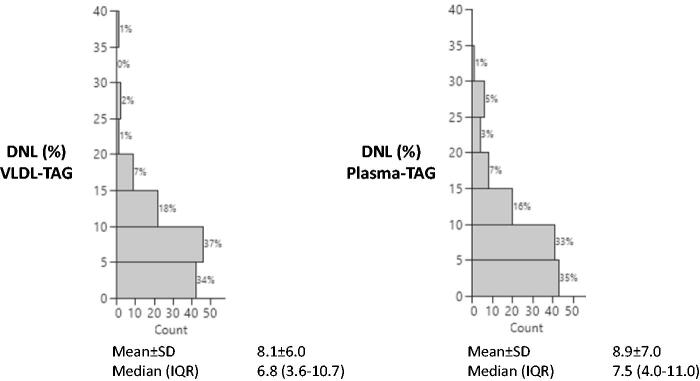
Histograms showing the distributions, means, and medians of DNLVLDL-TAG and DNLPlasma-TAG. n = 123.